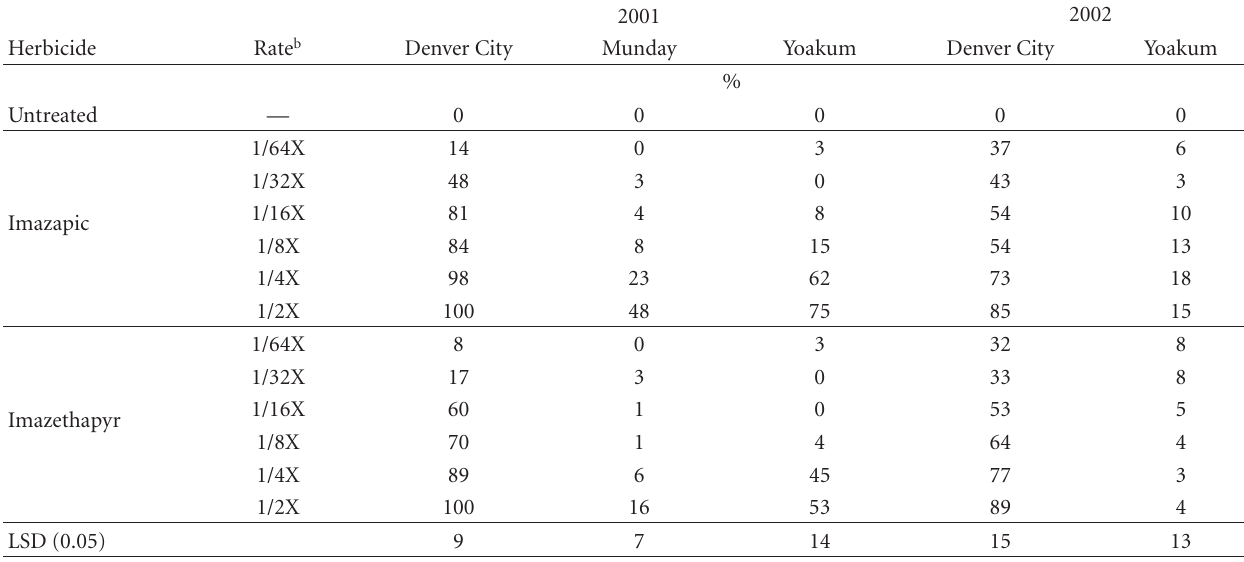
Table 2: Cotton stunting as a ff ected by simulated rates of imazapic and imazethapyr. a